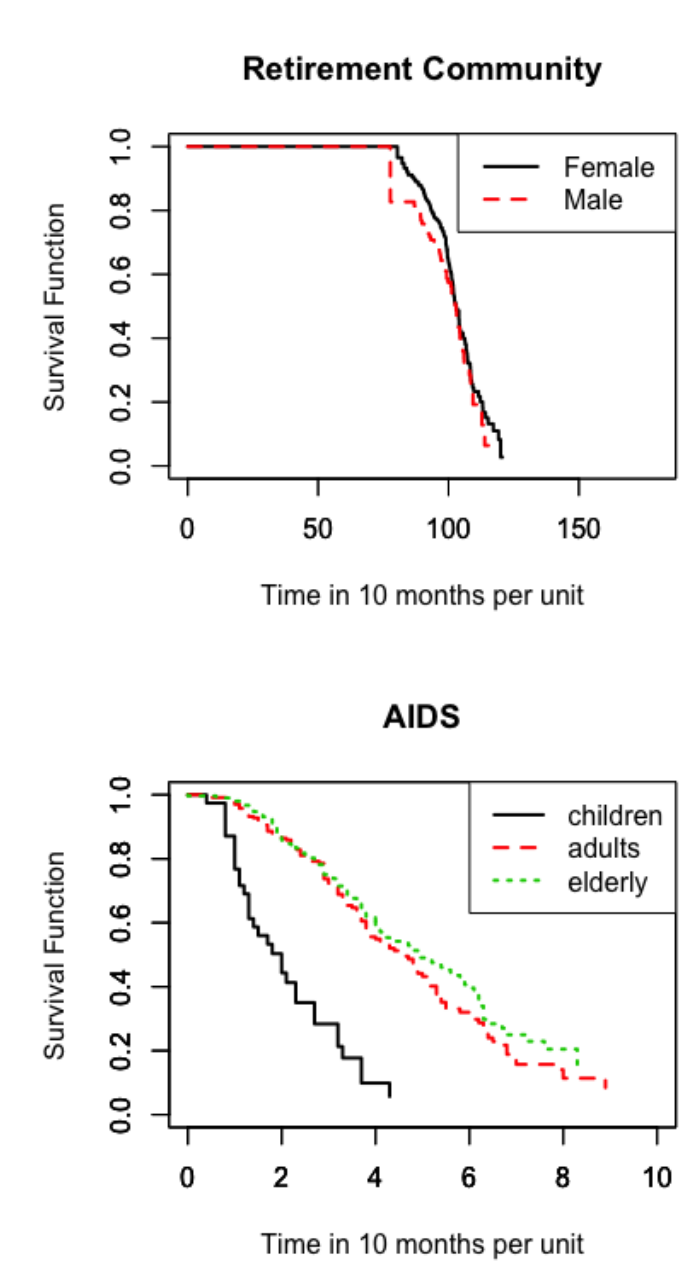
Figure 1. The survival curves for the retirement center data and AIDS data.